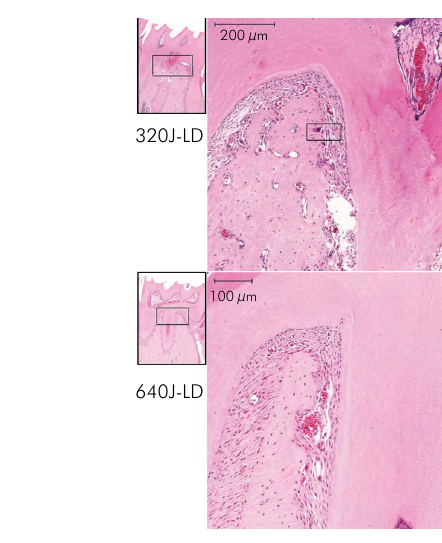
Figure 4. cont. e) Furcation region. Photomicrographs showing intense 320J-LD group showed well-cellularized and well-vascularized connective tissue and Interstitial hemorrhage; whereas the 640J-LD group presented well-organized collagen fibers and formed bone trabeculae with mature aspect, eliciting a better preservation of the alveolar bone microstructure among the diabetic groups. (Hematoxylin and Eosin; Bars = 200 µm and 100